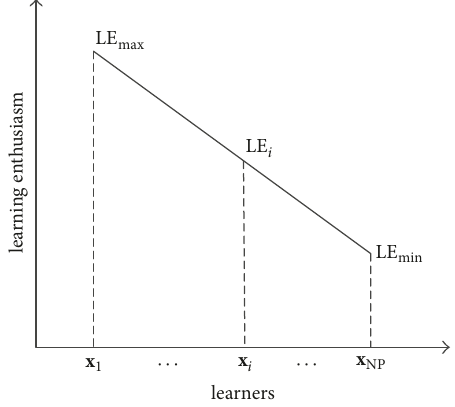
Figure 1: Learning enthusiasm curve.